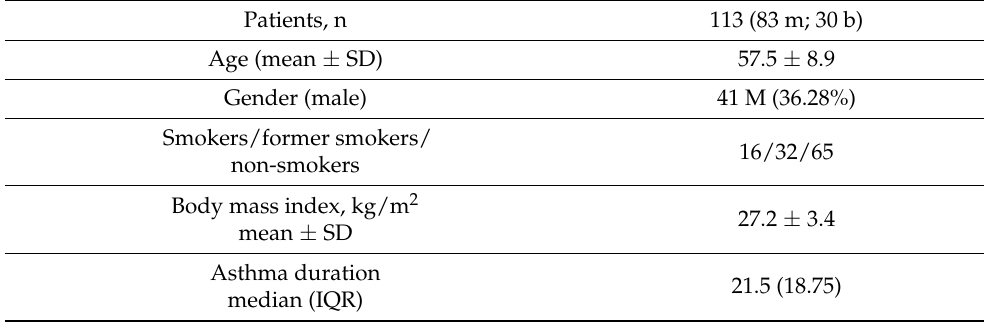
Table 1. Baseline characteristics of the study population (m: mepolizumab-treated; b: benralizumab-